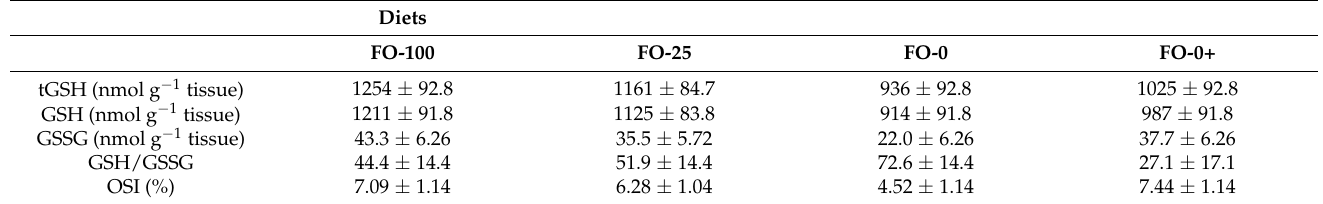
Values represent the mean ± standard error ( n = 9). Table 3. Lipid peroxidation levels (nmols MDA/g − 1 tissue) in the liver, foregut, hindgut, white muscle, and red muscle of Mediterranean yellowtail ( Seriola dumerili ) fed the experimental diets for 109 days.